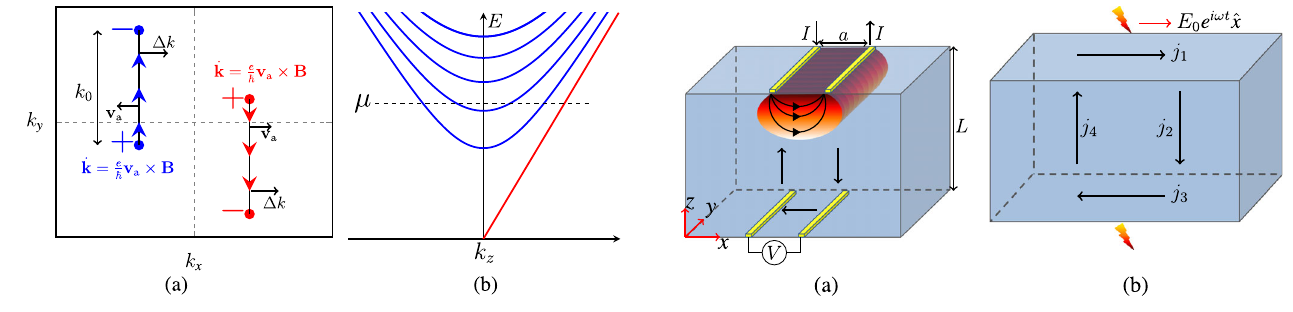
FIG. 2. (a) dc configuration: A current, I , is injected via the upper left contact and withdrawn from upper right contact. The voltage difference between the lower contacts is measured. Without the nonlocal orbits, current flow in a “ cigar ” -shaped configuration between the contact. (b) ac configuration: Current cycle due to a pulse of EM field on the top surface leads to emission from the lower